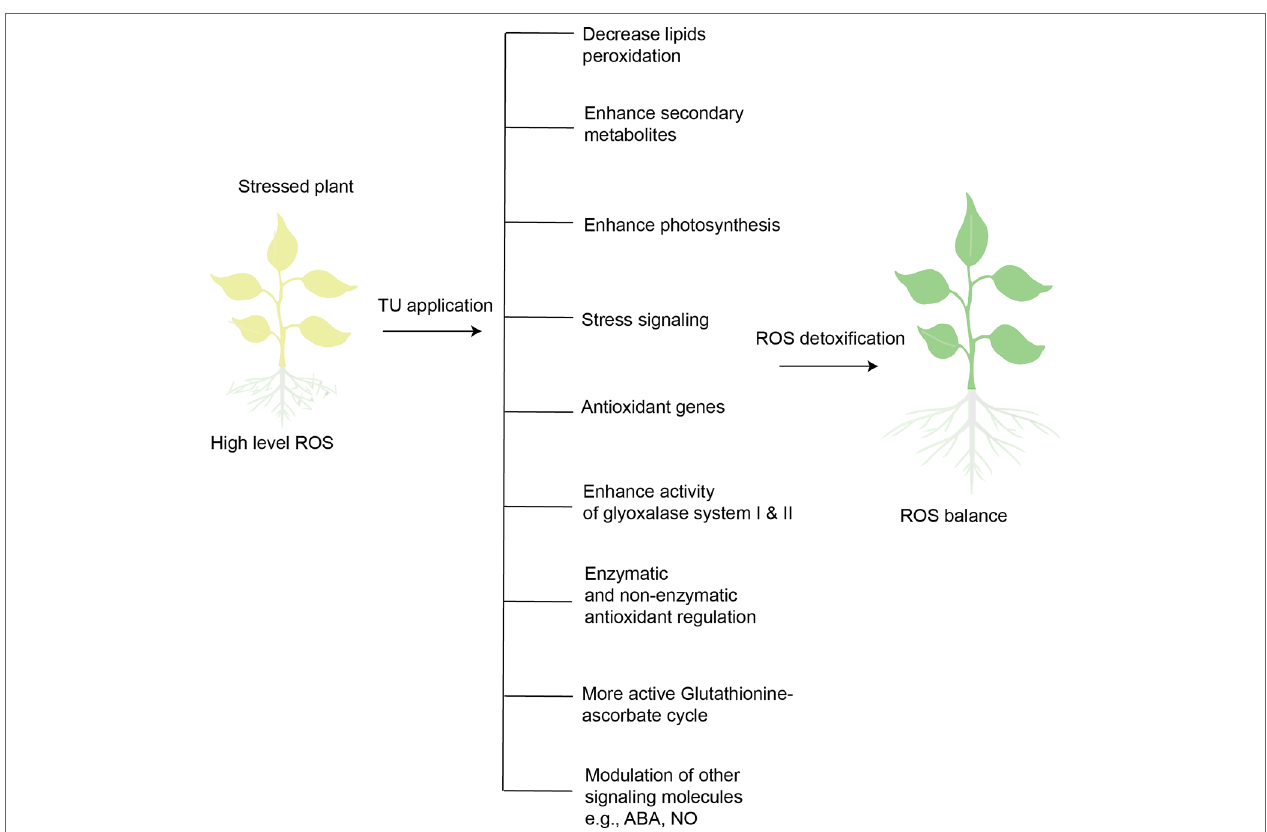
FIGURe 3 | Overview of TU-mediated ROS-detoxification in stressed plants. Plants exposed to abiotic stresses (heat, cold, drought, salinity, heavy metal stress) increase ROS levels. High-level ROS can disturb normal cell functioning, ultimately leading to cell death. TU application is capable of detoxifying ROS in stressed plants through the mechanisms